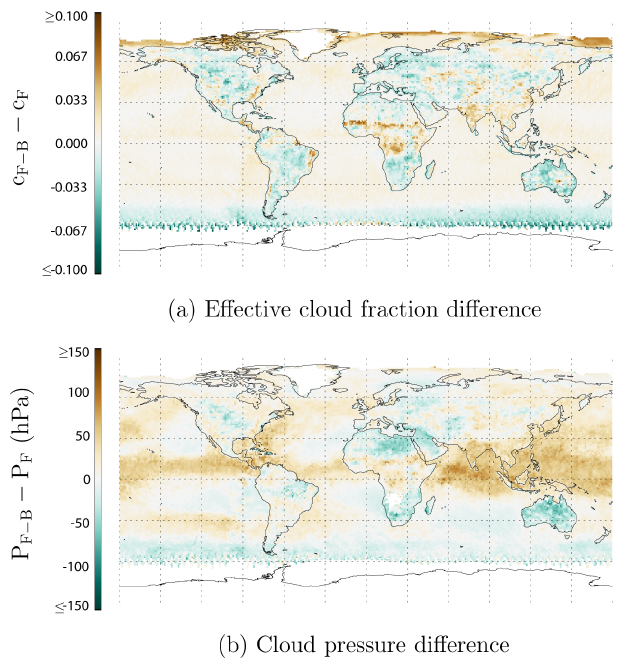
Figure 7. Differences of effective cloud fraction and cloud pressure between FRESCO-B and FRESCO for July 2014.